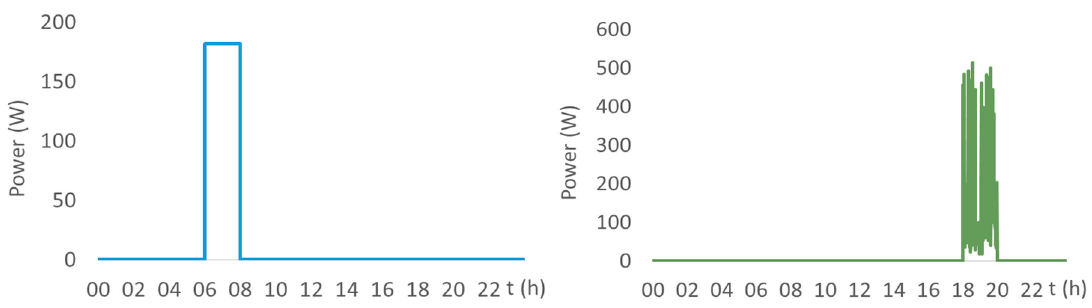
Figure 9. Flexibility Forecast Diagram for REFIT dataset for the building 15 morning period from 06:00 to 08:00 ( left ), and the afternoon period from 18:00 to 20:00 ( right ).